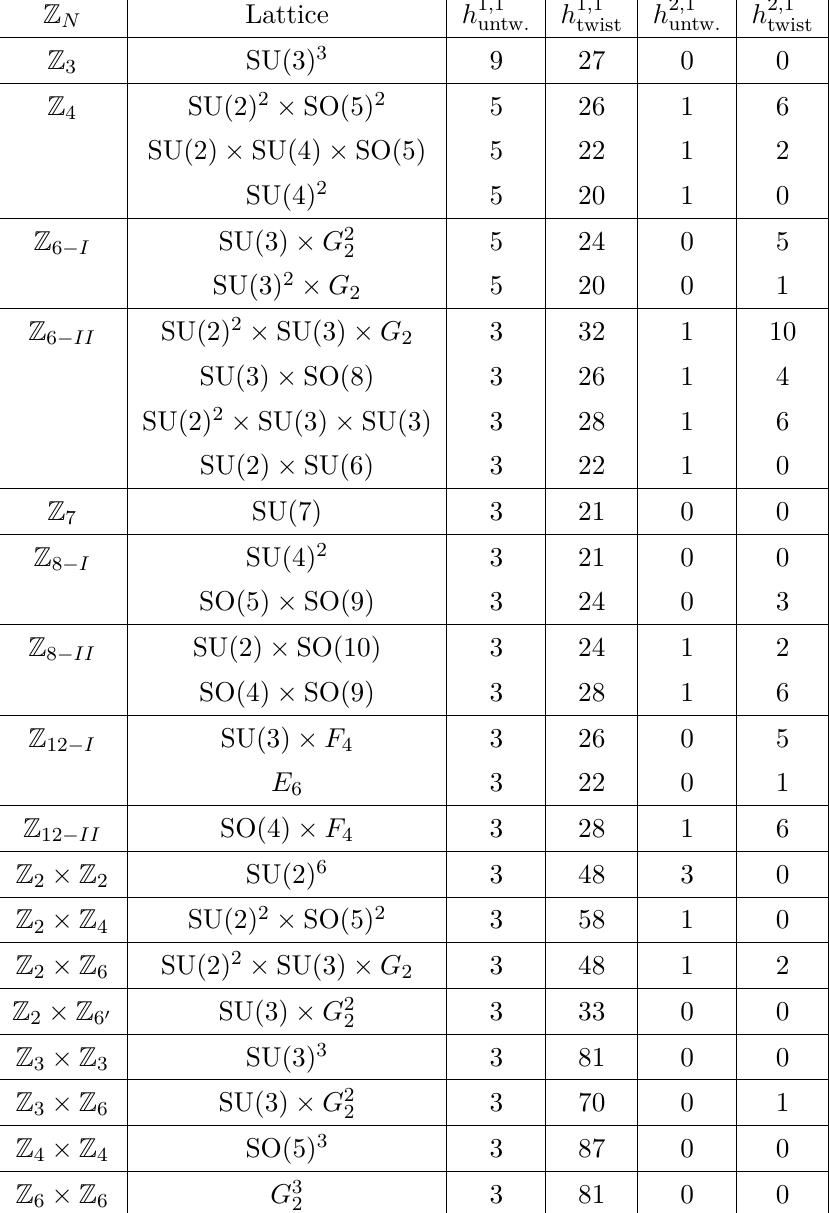
Table 1 . Hodge number on toroidal orbifolds [29,